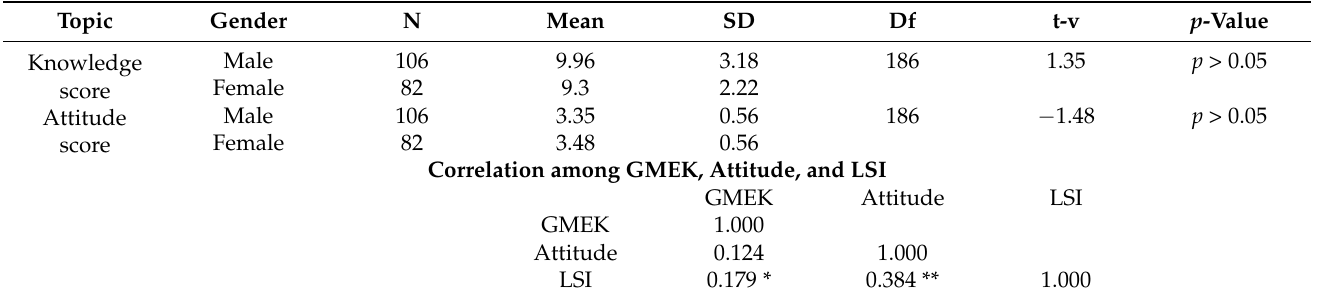
Table 5. Mean knowledge and attitude scores based on the students’ gender. t p -values are at a 95% confidence level. Correlations among general marine environmental knowledge, attitude, and land–sea interaction scores. t-v indicates